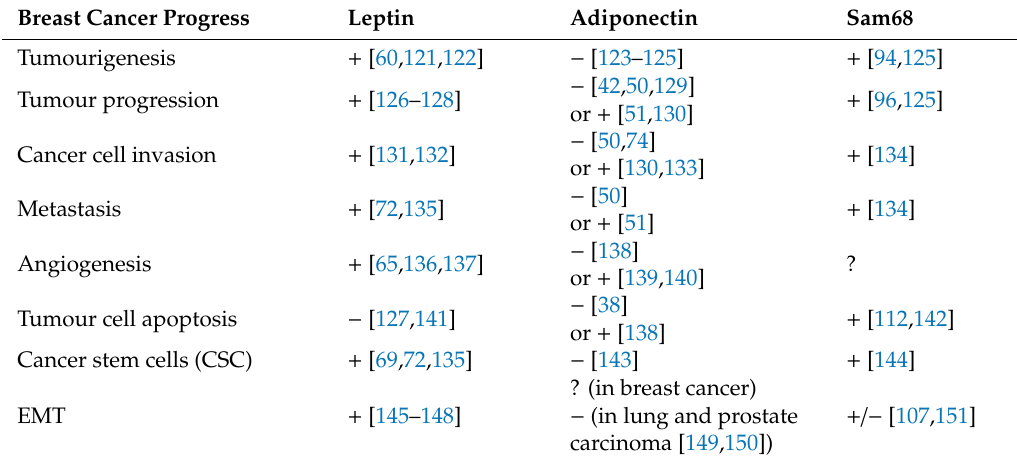
Table 1. The role of leptin, adiponectin, and Sam68 in breast cancer: ( + ) positive regulation (activation), (-) negative regulation (inhibition), ( +/ -) positive or negative regulation depending on phosphorylation